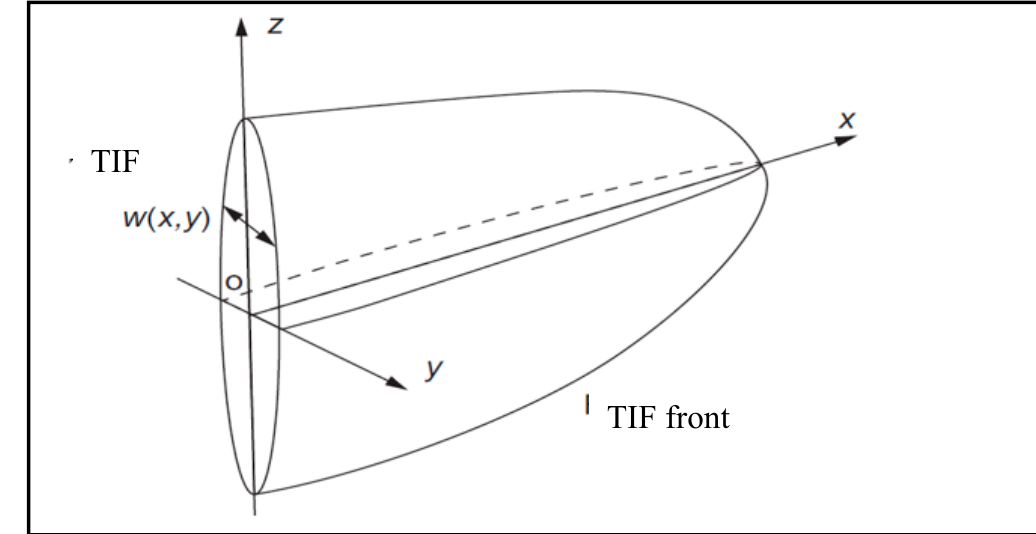
Figure 10. Shape of a TIF in the x-direction [20].